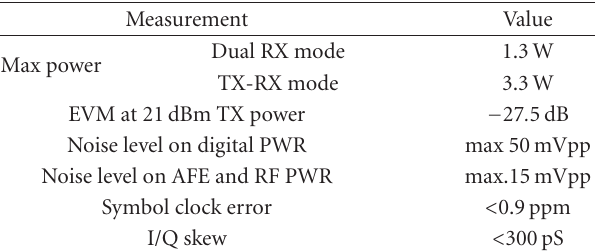
Figure 10: Simulation of impedance versus frequency for di ff erent used types of Murata capacitors [9]: (1) 330 pF 0402 size, X7R, GRM series, (2) 10 nF 0402 size, X7R, GRM series, (3) 0.15 uF, 0402 size, Y5R, GRM series, (4) 10 nF, 0306 size, X6S, LLL series, (5) 0.1uF 0204 size, X6S, LLL series.